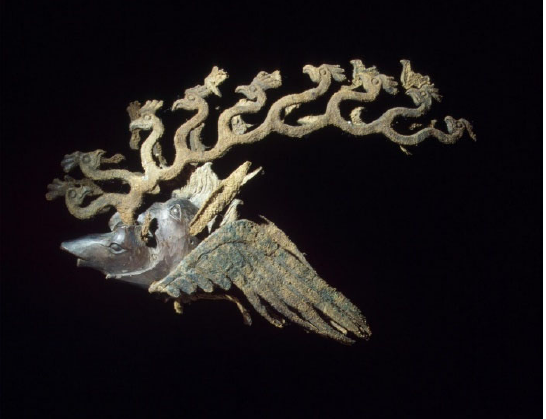
Figure 17. Finial in the form of a griffin holding a stag’s head in its beak (SHM inv. no. 1684 ‐ 169); cedar